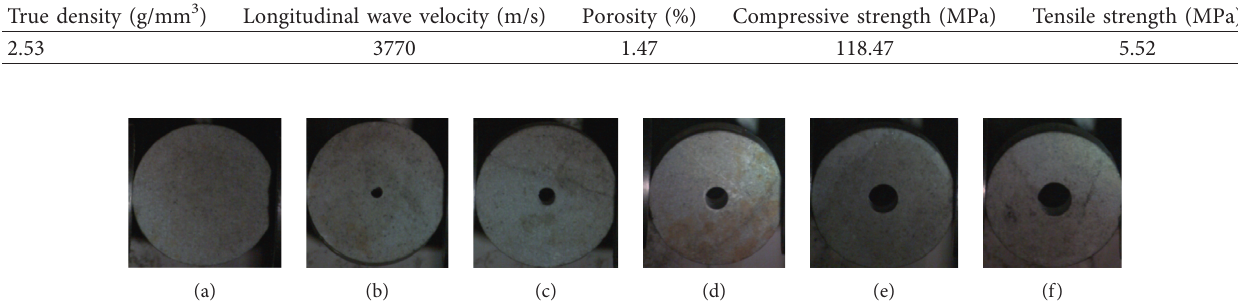
Figure 1: Sandstone specimens with precentral hole disc and complete disc: (a) d/D � 0; (b) d/D � 0.08; (c) d/D � 0.12; (e) d/D � 0.2; (f) d/D � 0.24.